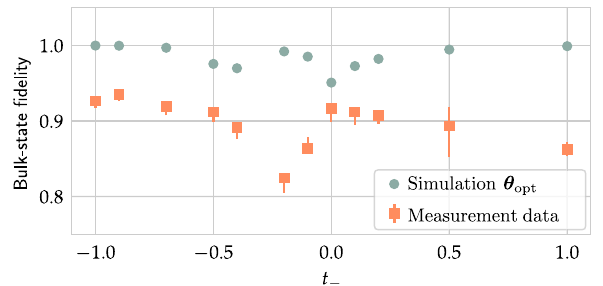
FIG. 15. Fidelity of the variationally implemented state in the bulk obtained by state tomography on the bulk qubits. A simulation of the state using the optimal parameters θ for direct comparison. Experimentally, we achieve a fidelity of > 80% over the whole parameter regime for the case δ ¼ 0